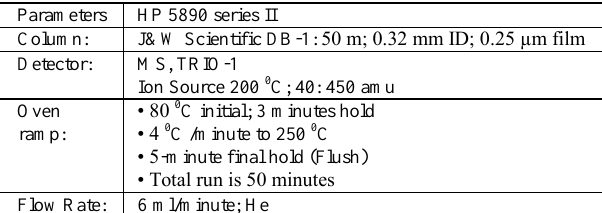
Table 3. Gas-chromatographic parameters used for speciation of commer- cial gasoline Parameters HP 5890 series II Column: